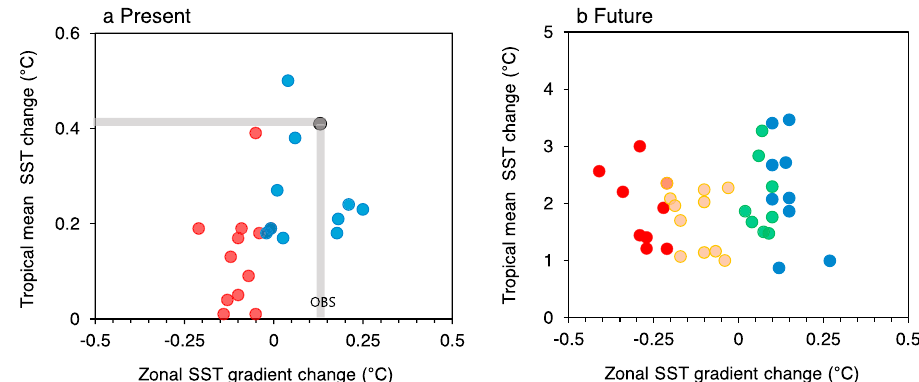
Fig. 1 Two projections of zonal SST gradient change. a Relationship between mean sea surface temperature (SST) changes in the tropical Paci fi c ( y -axis, unit: °C) and zonal SST gradient changes ( x -axis, unit: °C) in climate models during present periods. b Same as a but for future periods. For present periods, the differences between the mean SST (or zonal SST gradient) of 1940 – 1970 and 1980 – 2005 are used. The zonal SST gradient is measured as the difference between the western Paci fi c SST (5°S – 5°N, 155°E – 175°W) and the eastern Paci fi c SST (5°S – 5°N, 115°W – 145°W). The Extended Reconstructed Sea Surface Temperature version 5 dataset is used for observation. The observations are marked with a gray line. For future periods, the differences between tropical mean SST (20°S – 20°N) of the Representative Concentration Pathway (RCP) 4.5/8.5 (2038 – 2087) scenario and that of the historical simulation (1943 – 1992) are used. The zonal SST gradient changes are de fi ned as the differences of zonal SST gradient between RCP4.5/8.5 and historical scenarios. Red (orange) dots represent the models experiencing strong (weak) El Niño-like mean SST changes, while blue (green) dots indicate strong (weak) La Niña-like mean SST changes in the